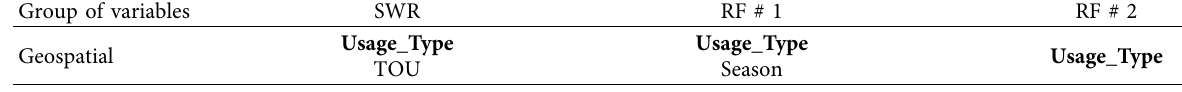
Table 7: Comparison of predictor variables selected by SWR and RF feature selection methods. Group of